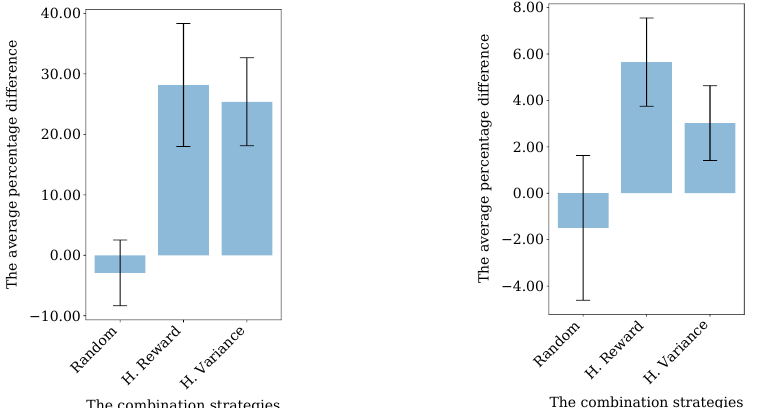
Figure 14. The results of combination strategies for ( left) meeting in grid and ( right ) fire fighting problem for all problem sizes. The results are averaged over the percentage difference of the strategies from DecMCTS (cid:101) greedy . The whiskers show the standard error. −